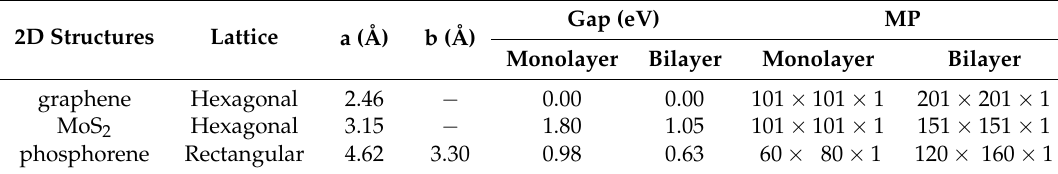
Table 1. The lattice constants ( a , b ) and band gap (in eV) of different 2D crystalline materials. Sampling of the reciprocal space Brillouin zone (BZ) is done by a Monkhorst–Pack (MP) grid for the considered 2D